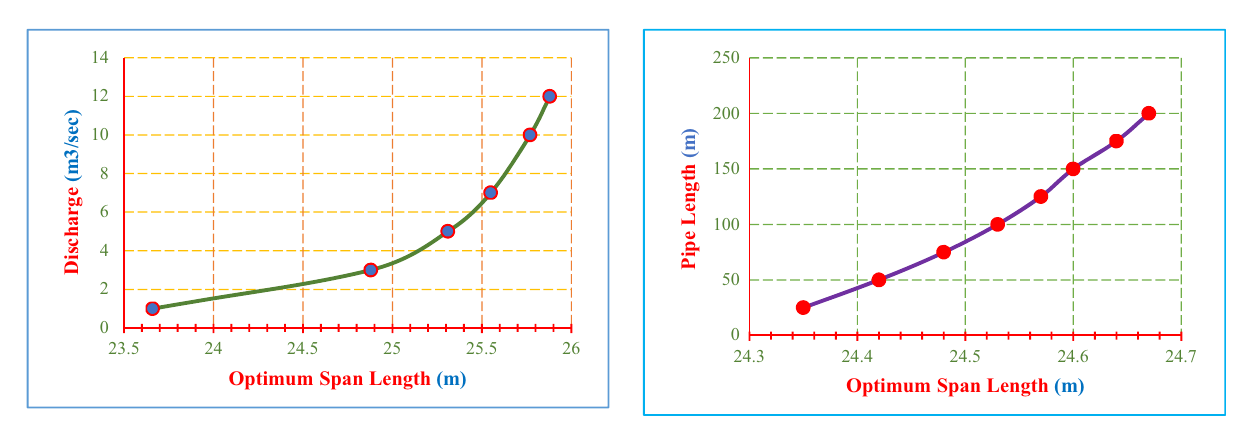
Figure 6: Optimum span length vs pipe